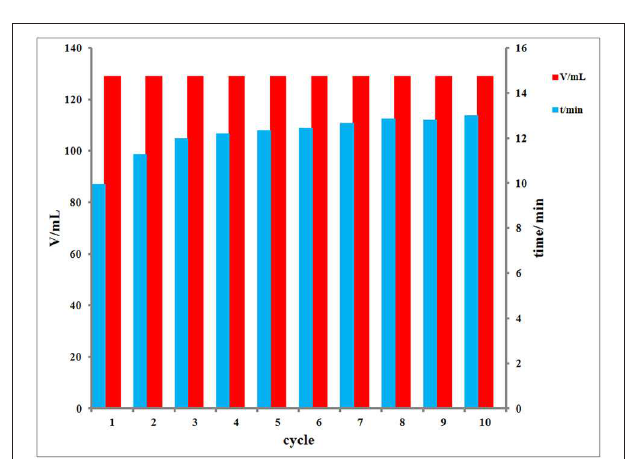
FIGURE 7 | The volume and time for the Ru/PAF-72 catalytic hydrolysis of AB from 1st to 10th cycles at 298K.